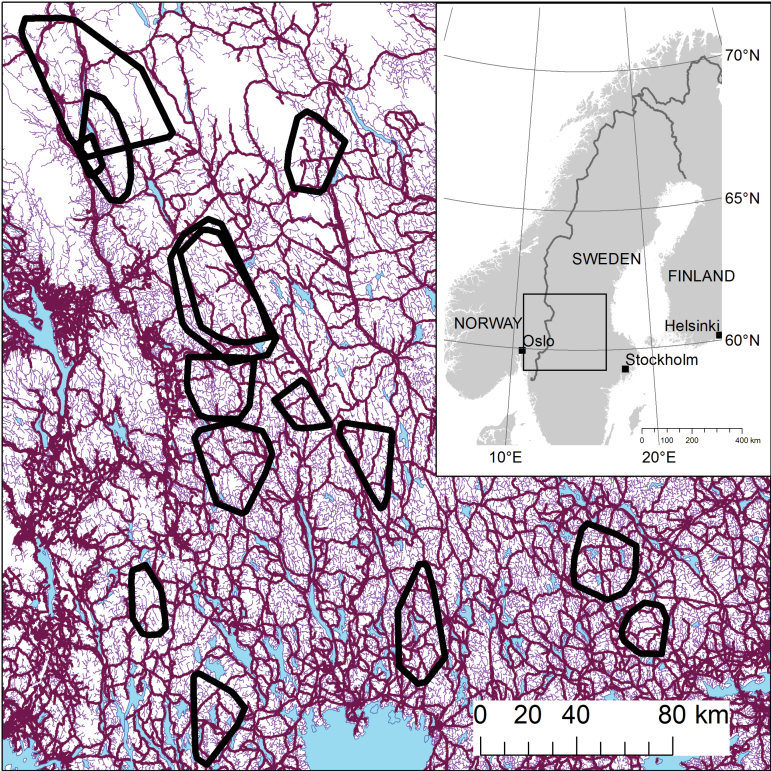
Location of wolf territories included in this study (black outlines), and all main roads (bold purple lines) and gravel roads (thin purple lines) within the study area. The study area comprised most of the wolf breeding range on the Scandinavian Peninsula (inset).